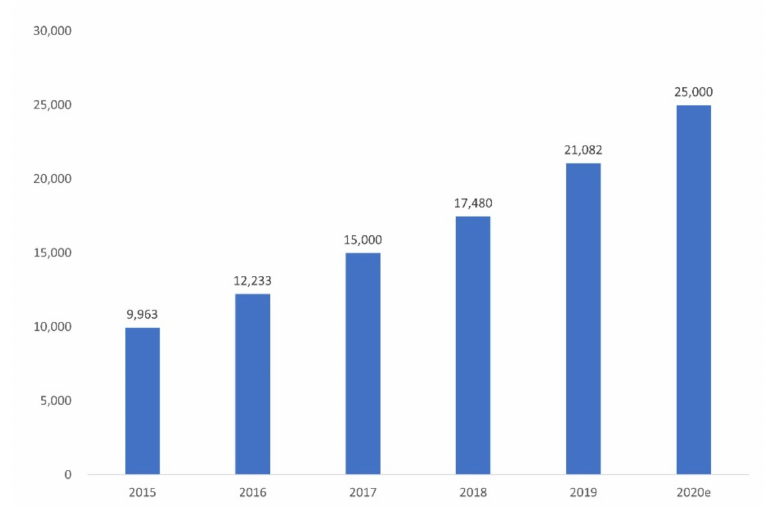
Figure 1. Output scale of China’s intelligent manufacturing industry; unit: 100 million RMB. (Source: Forward Industry Research Institution).